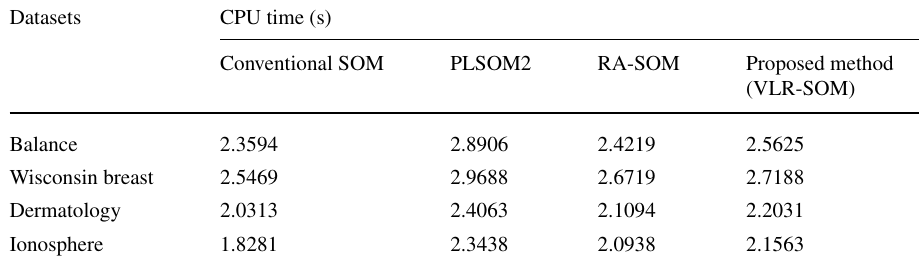
Table 12 Comparison of CPU time for conventional SOM, PLSOM2, and VLR-SOM algorithms on four UCI benchmark